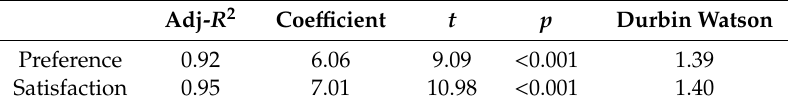
Table 10. Preference and satisfaction regression model with cookie box density.